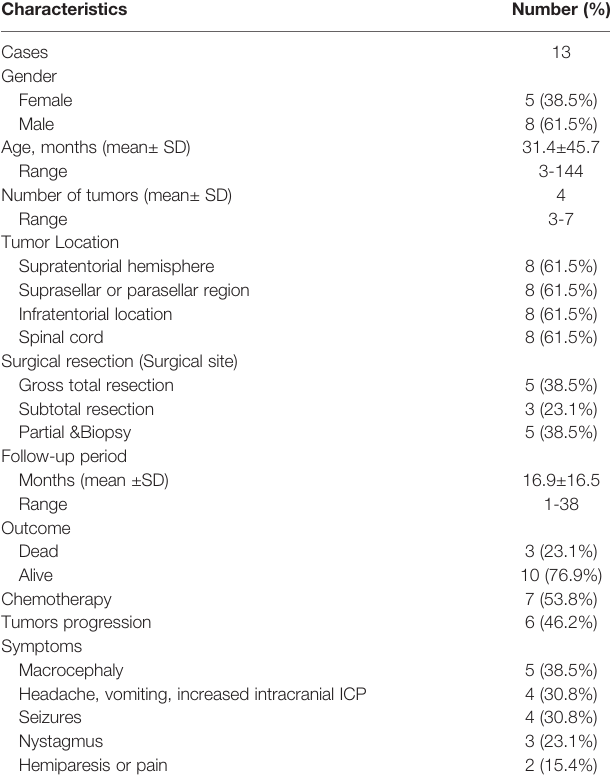
TABLE 1 | Patients'